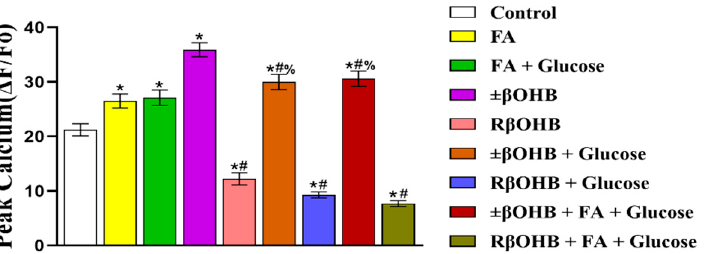
Figure 6. Quantification of Fluo4 calcium transient (Ca 2+ ) amplitudes recorded from iPS-CMs cultured in various media. Peak calcium under control media, fatty acid media, fatty acid + glucose media, ± β OHB, R β OHB, ± β OHB + glucose media, R β OHB + glucose, ± β OHB + FA + glucose media, or R β OHB + FA + glucose media treatment. * p < 0.008 vs. control. # p < 0.008 vs. ± β OHB. % p < 0.008 vs. R β OHB.